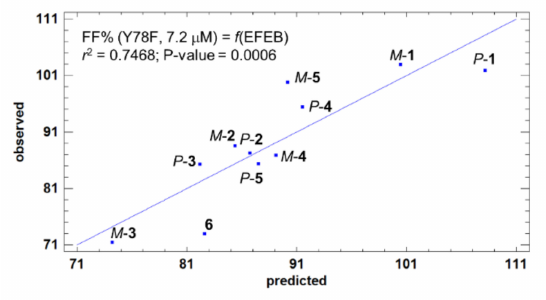
Figure 6. Linear regression analysis describing the relationships between FF% (Y78F-TTR, inhibitor concentration = 7.2 µ M) and calculated EFEB by docking in the T 4 pocket